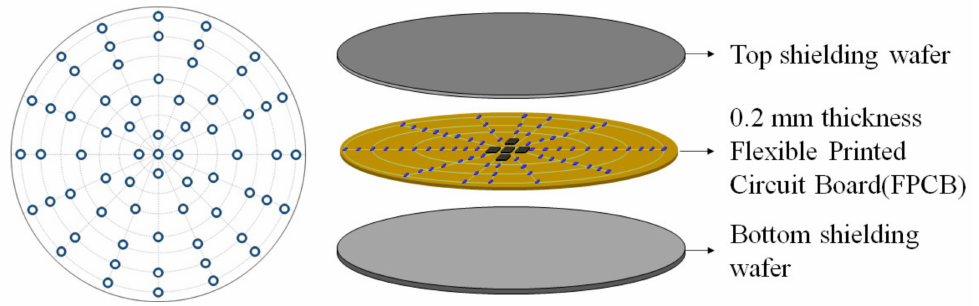
Figure 1. TMU locations and overall structure of